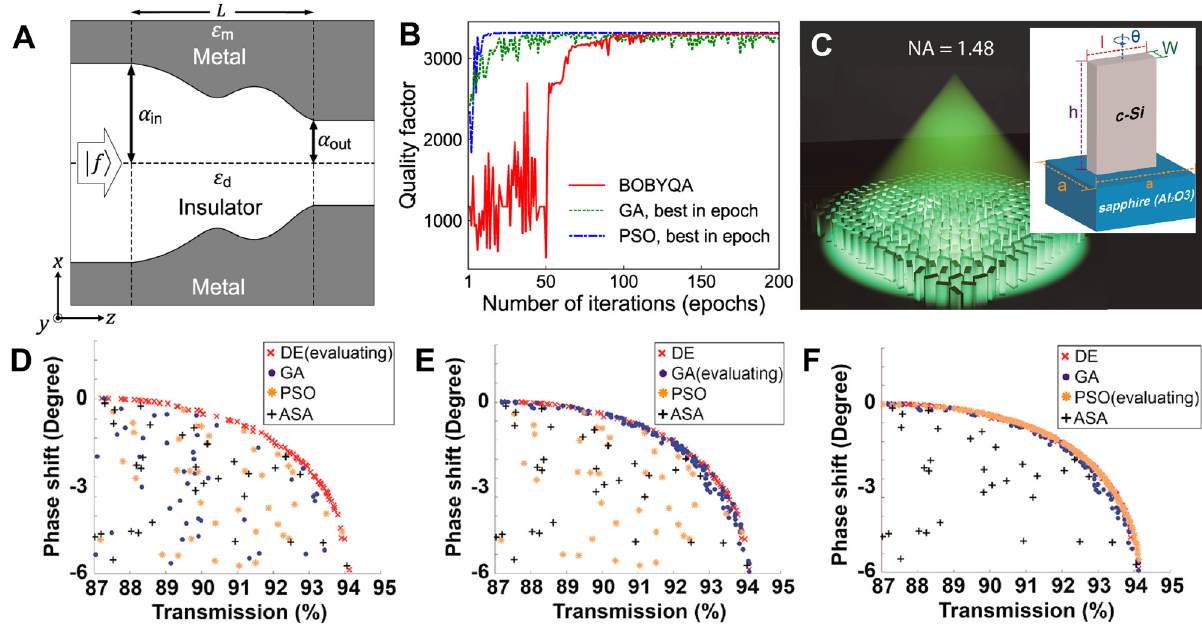
Figure 7: Works for nanophotonic device design depicting comparison between classical methods and a hybridized method consisting of them. ( A ) Schematic of free-form MIM light trapping waveguide. ( B ) Quality factor evolution along the iterations (epochs) of optimization. Solid red line, dotted green line, and dash-dotted blue line shows optimization progress for BOBYQA, GA, and PSO, respectively. A , B adapted with permissionfrom[79].Copyright2019,AmericanPhysicalSociety.( C )Renderedimageofproposedultrahigh-NAmetalens.Insetshowstheunit cell composing the metalens, which is being optimized. ( D – F ) The population distribution showing phase shift and transmission, during optimization iterations at which DE ( D ), GA ( E ), and PSO ( F ) are evaluated. C – F Adapted with permission from [91]. Copyright 2018, American Chemical